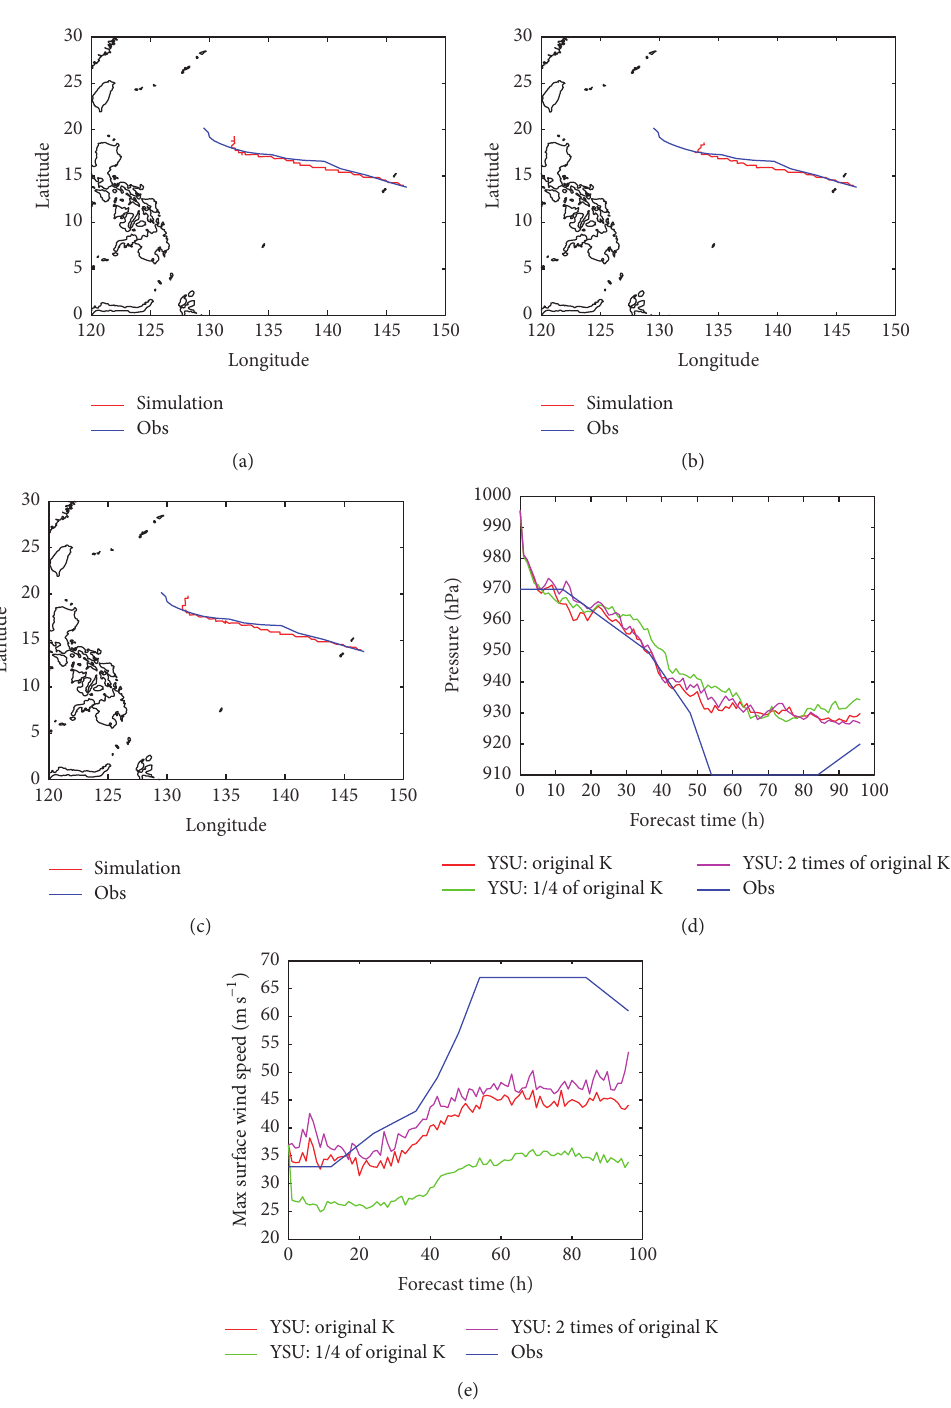
However, the K025 deteriorates the averaged AEs of 24 h- CSLP and 96 h-CSLP by 40.3% and 54.0%, respectively. For the averaged AEs of 24 h-MWSP, 48 h-MWSP, 72 h-MWSP, and 96 h-MWSP, the K200 improves them by 16.1–50.1%, whereas the K025 deteriorates them by 78.1–105.9%.